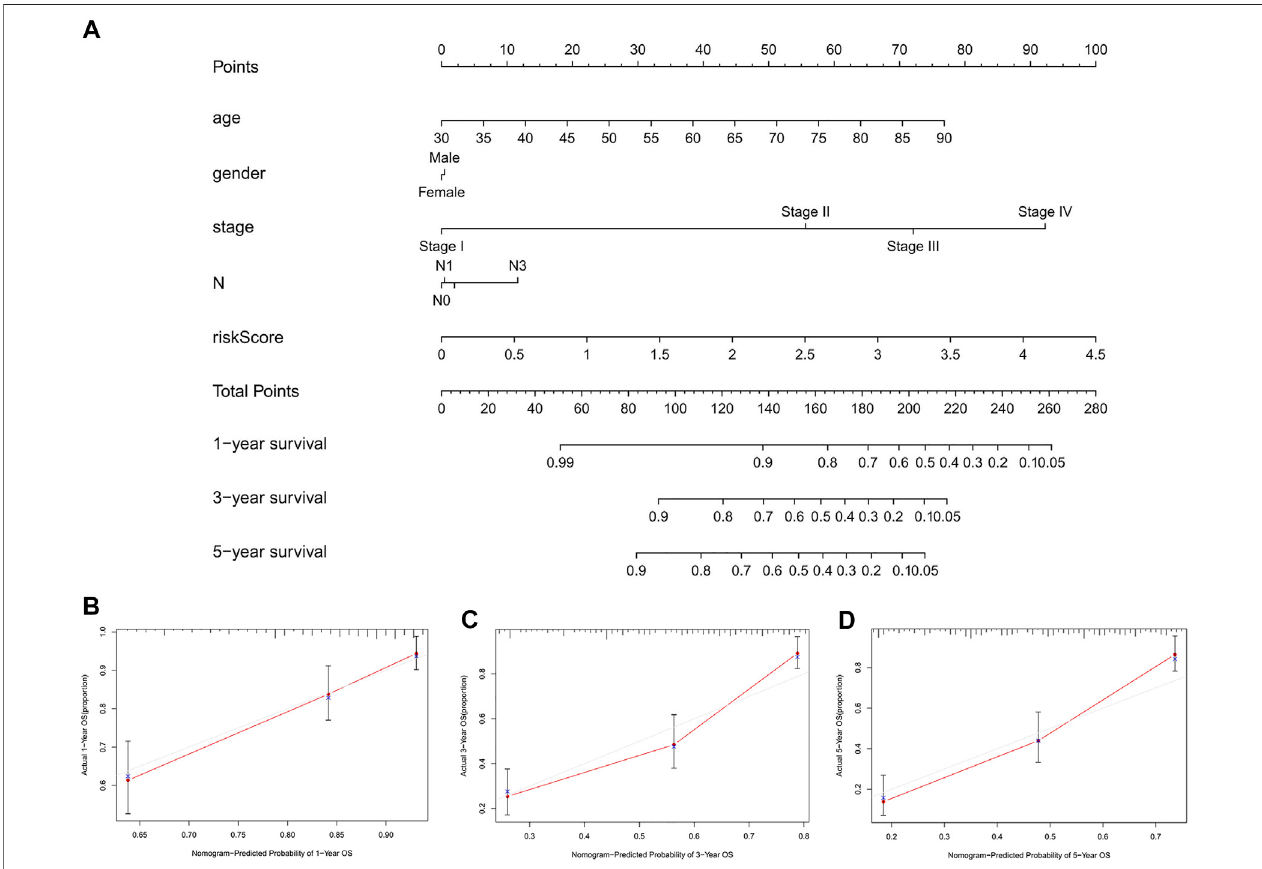
FIGURE6| Constructionandveri fi cationofthenomogram. (A) Anomogramcombiningclinicopathologicalvariablesandriskscorepredicts1,3,and5yearsOSof BC patients. (B-D) The calibration curves test consistency between the actual OS rates and the predicted survival rates at 1, 3 and 5 years. N, lymph node; OS, overall survival; BC, bladder